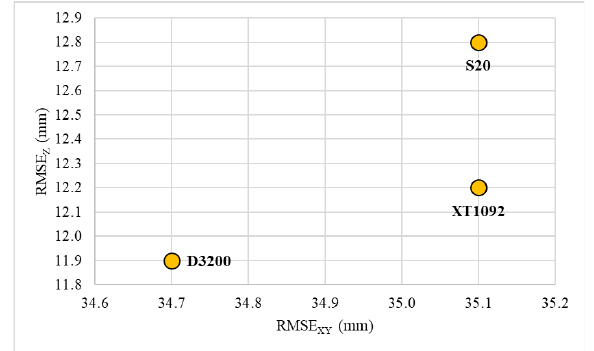
Figure 7 . Horizontal and vertical errors across camera models.